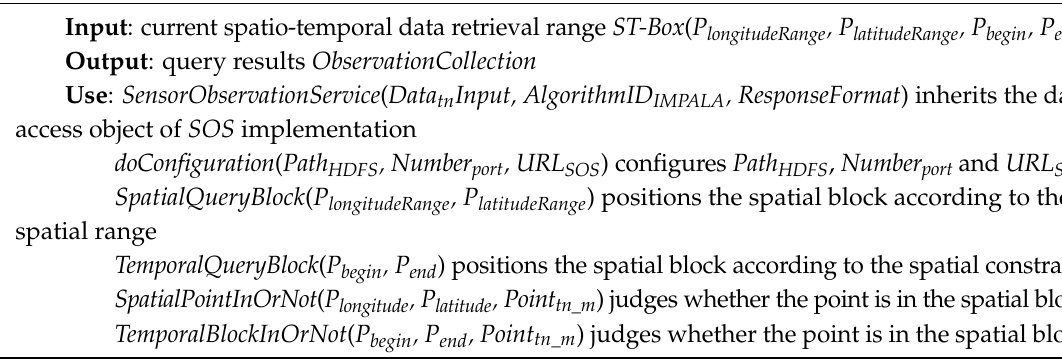
Algorithm 1. Algorithm of spatio-temporal trajectory data